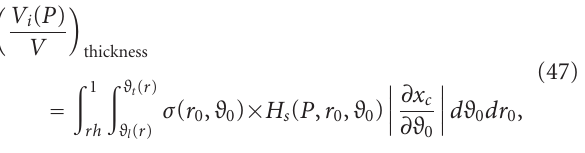
Figure 4: Chordwise coordinate transformation Ψ (as from